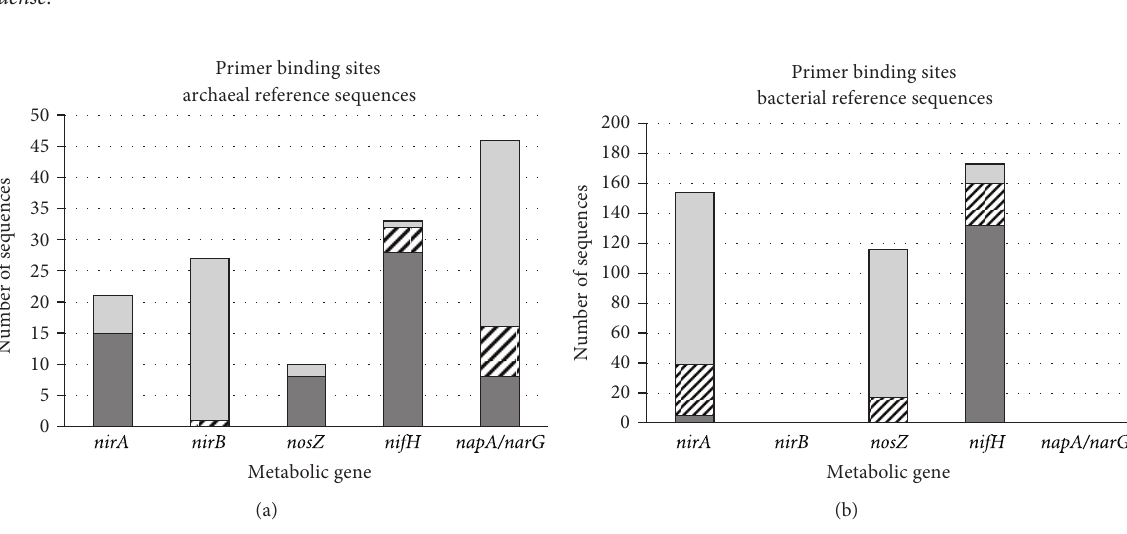
F 2: In silico evaluation of primer sets for the detection of archaeal metabolic genes. Archaeal (a) and bacterial (b) reference sequences containing the targeted metabolic gene were screened for binding sites for the gene-speci�c primers. �ar� grey: sequences with binding sites for both primers; hatched: sequences with binding sites for one primer; light grey: sequences without binding